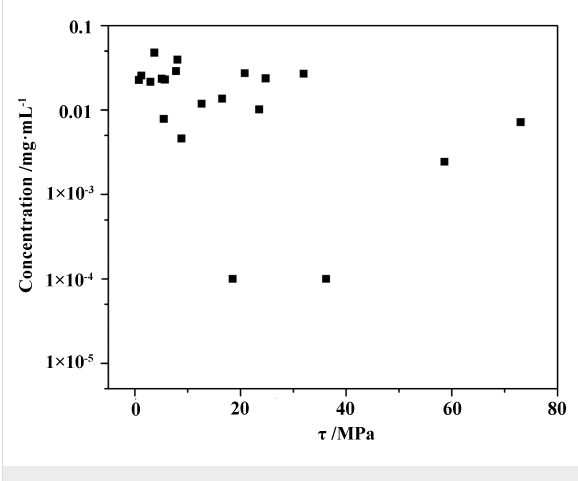
Figure 5: Concentration of KP 15 dispersions as a function of τ , τ = [( δ A,D − δ B,D ) 2 + ( δ A,P − δ B,P ) 2 /4 + ( δ A,H − δ B,H ) 2 /4].